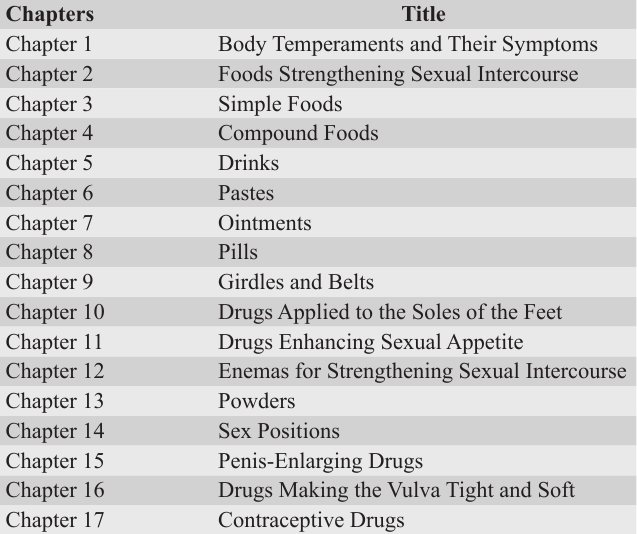
Table 1. The Index of Bahname Quoted by Uzel with Reference to